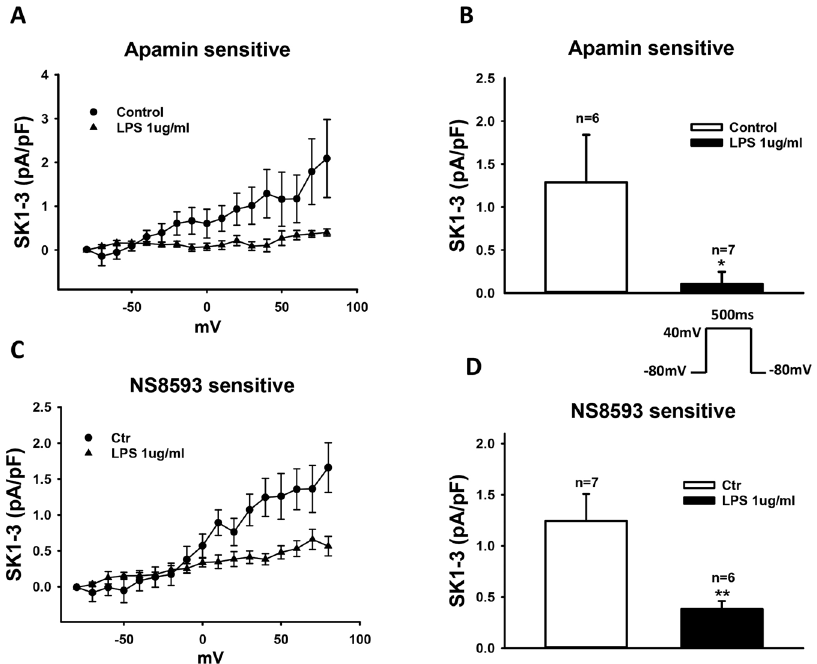
Figure 7. LPS-treatment attenuated SK1-3 channel currents (I SK1-3 ). Membrane currents were recorded in absence and presence of 100 nM apamin ( A and B ) or 10 µ M NS8593 ( C and D ), blockers of SK1-3 channels. The blocker-sensitive currents were analyzed as I SK1-3. ( A ) Current-voltage (I–V) relationship curves of apamin- sensitive currents recorded from − 80 to + 80 mV with the holding potential of − 80 mV. ( B ) Mean values of apamin-sensitive currents at + 40 mV. ( C ) I–V curves of NS8593-sensitive currents. ( D ) Mean values of NS8593-sensitive currents at + 40 mV. Values given are mean ± SEM. n, number of cells. * p < 0.05, ** p < 0.01.